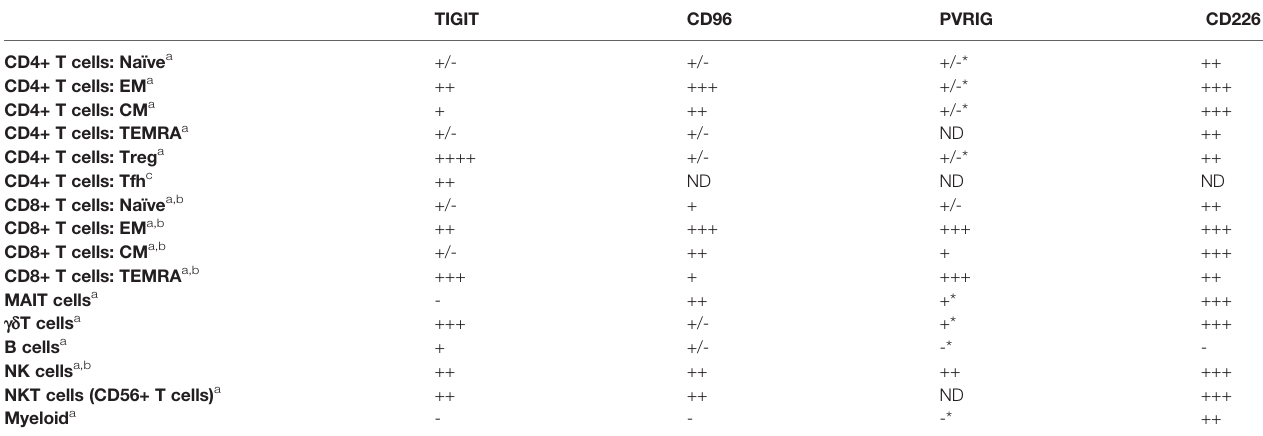
TABLE 1 | Expression of CD226 axis members on human immune populations. TIGIT CD96